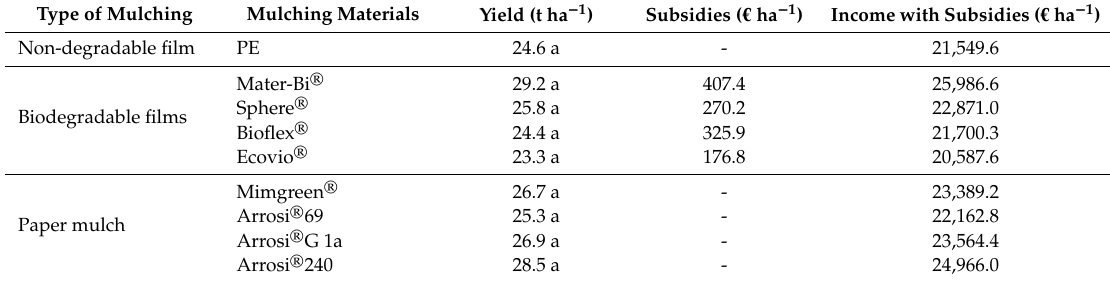
Table 5. Experimental yield (t ha − 1 ), subsidies, and total income obtained for mulching materials in open-air conditions in 2014.